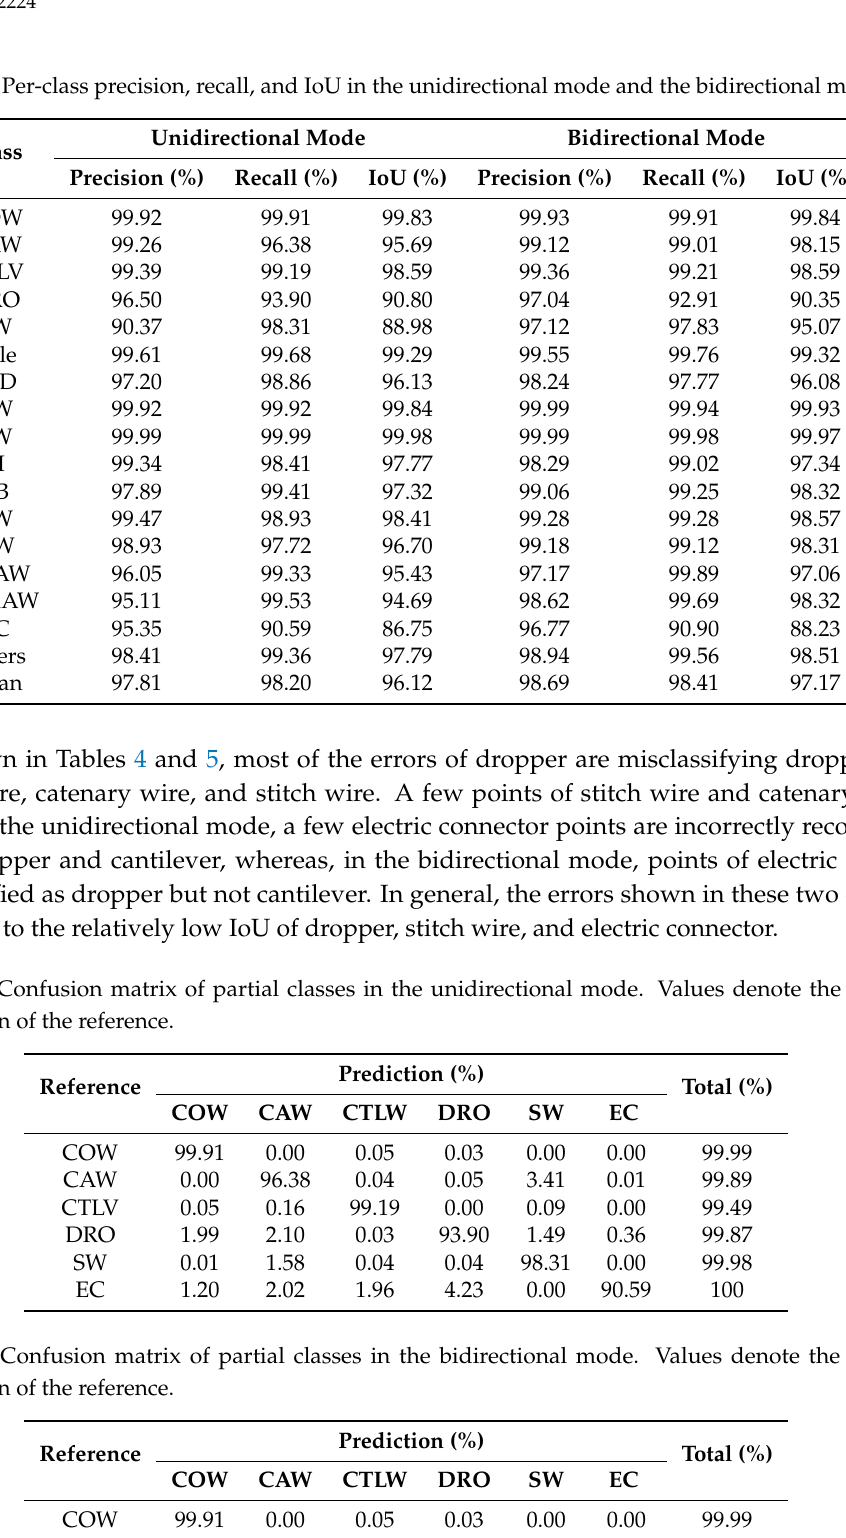
Table 3. Per-class precision, recall, and IoU in the unidirectional mode and the bidirectional mode. Class